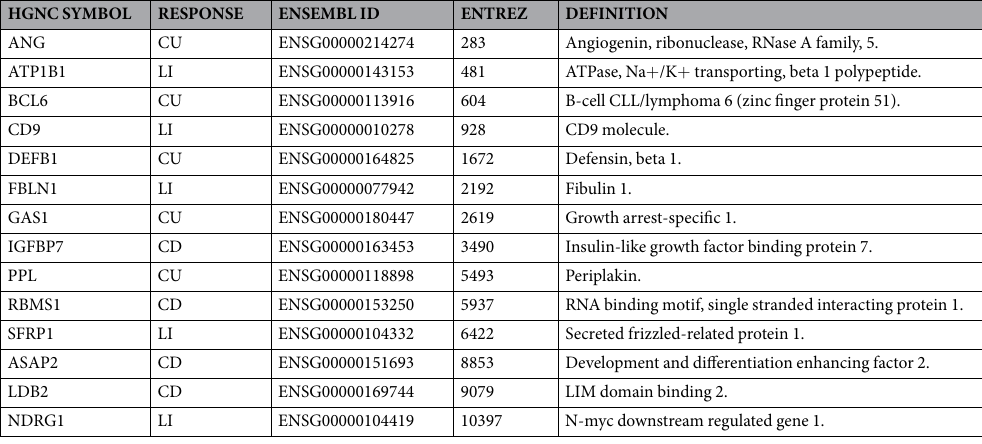
Table 2. Involution Transcriptome Core List. Codes for response are: (LD) linear decreasing, (LI) linear increasing, (CD) nonlinear concave down, and (CU) nonlinear concave up.